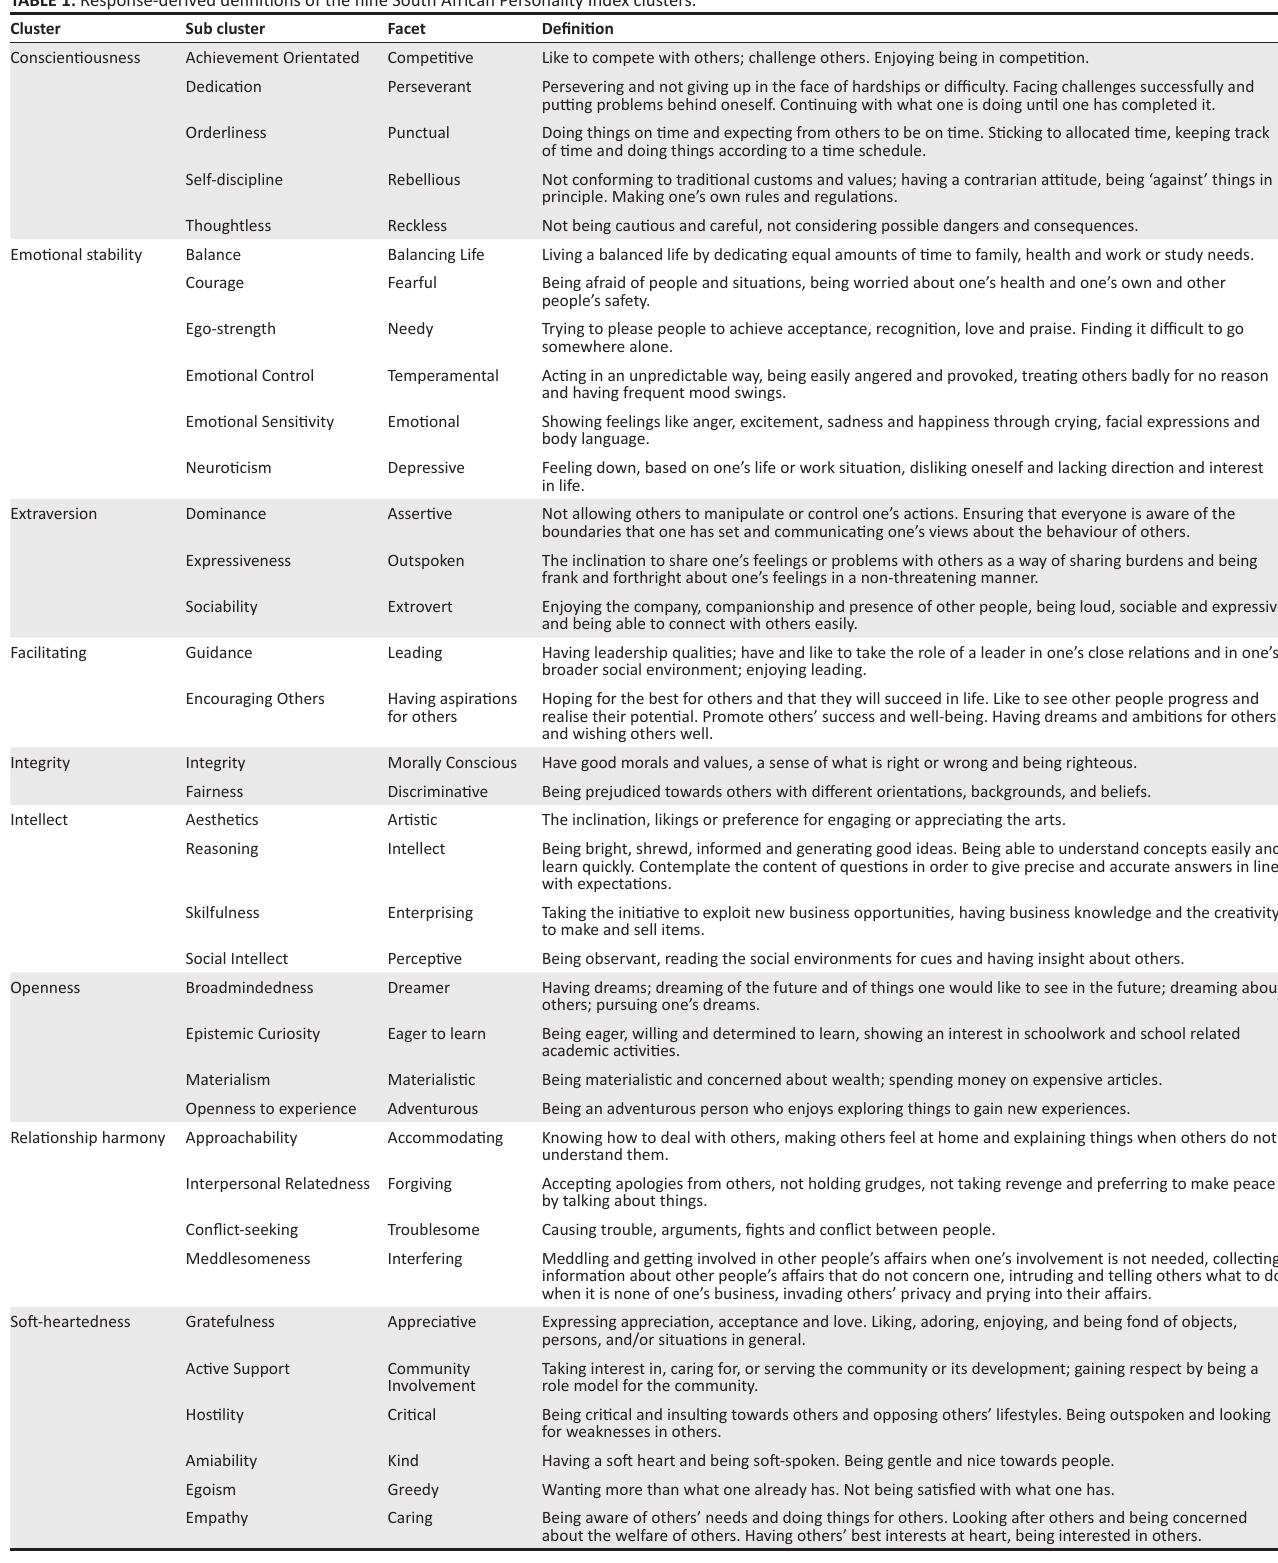
TABLE 1: Response-derived definitions of the nine South African Personality Index clusters. Cluster